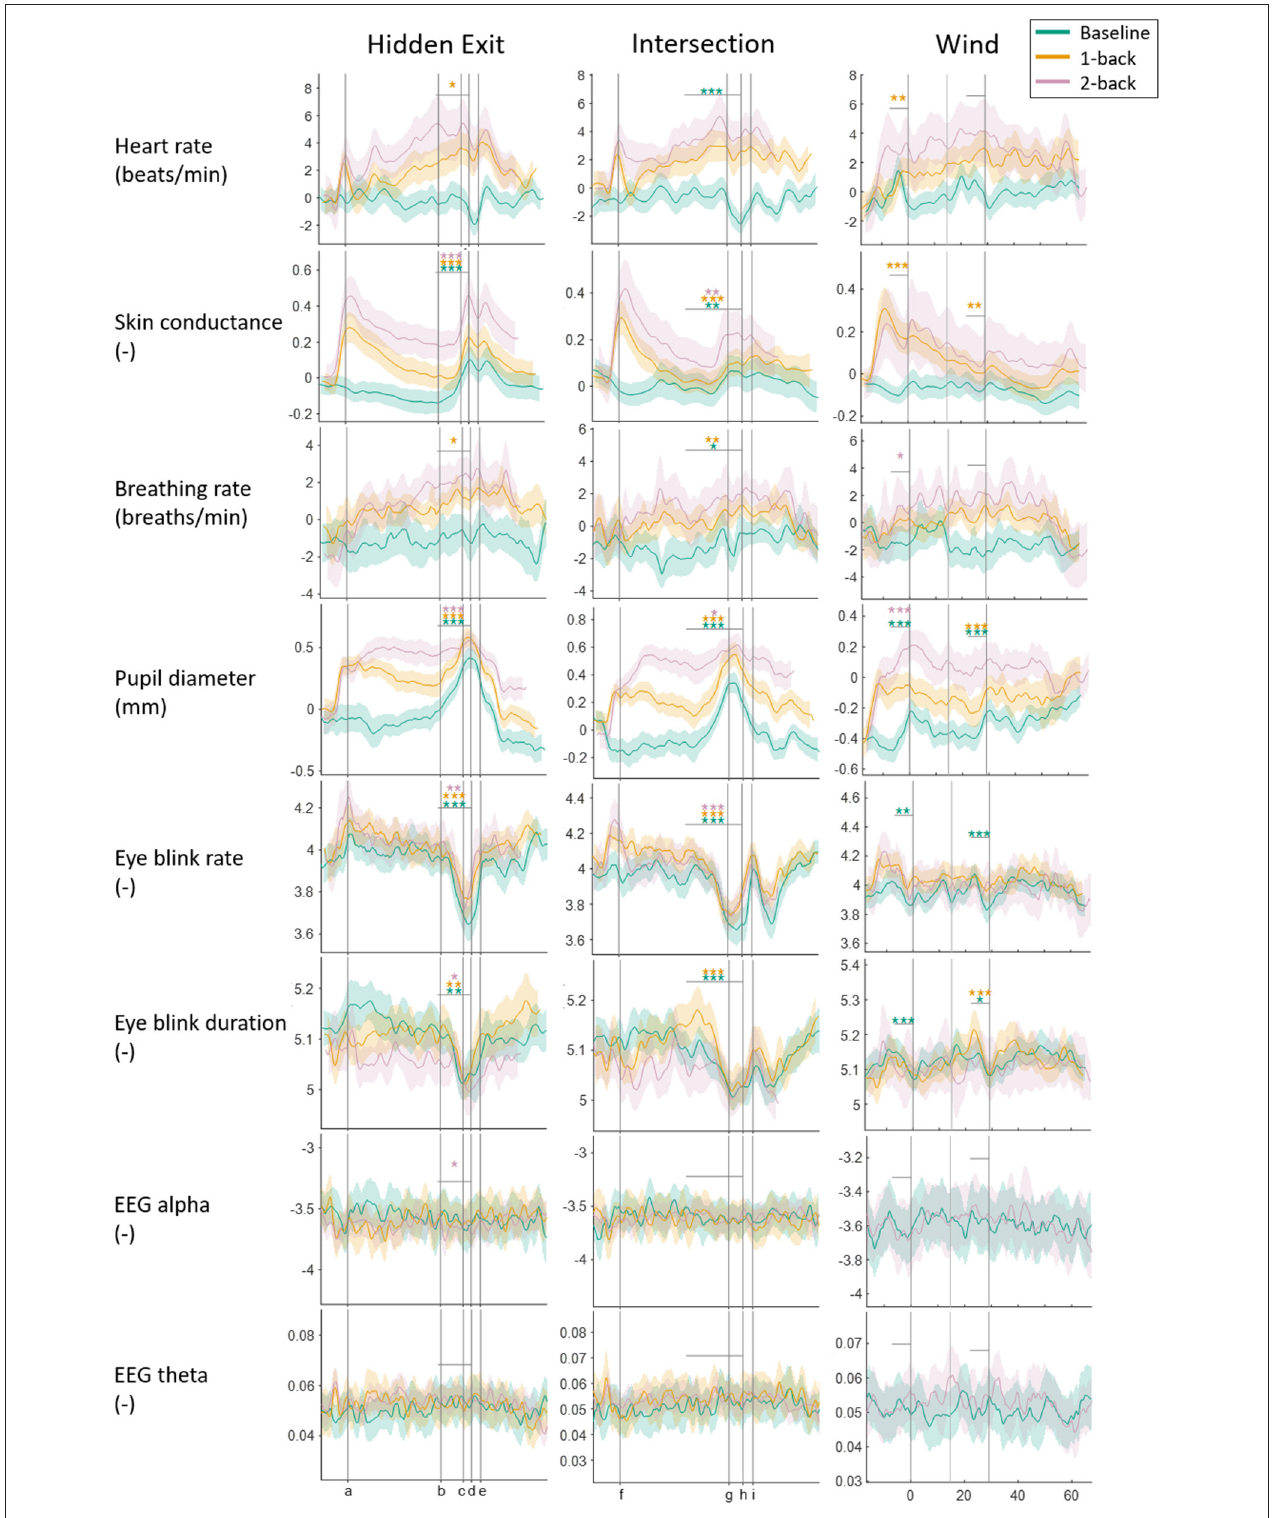
FIGURE 2 | Physiological measures plotted against the specific traffic events for each scenario and task condition. The thick colored lines are the means, and the shaded areas are the 95% confidence intervals. All measures, except Alpha and Theta, are normalized to reduce differences in absolute levels between